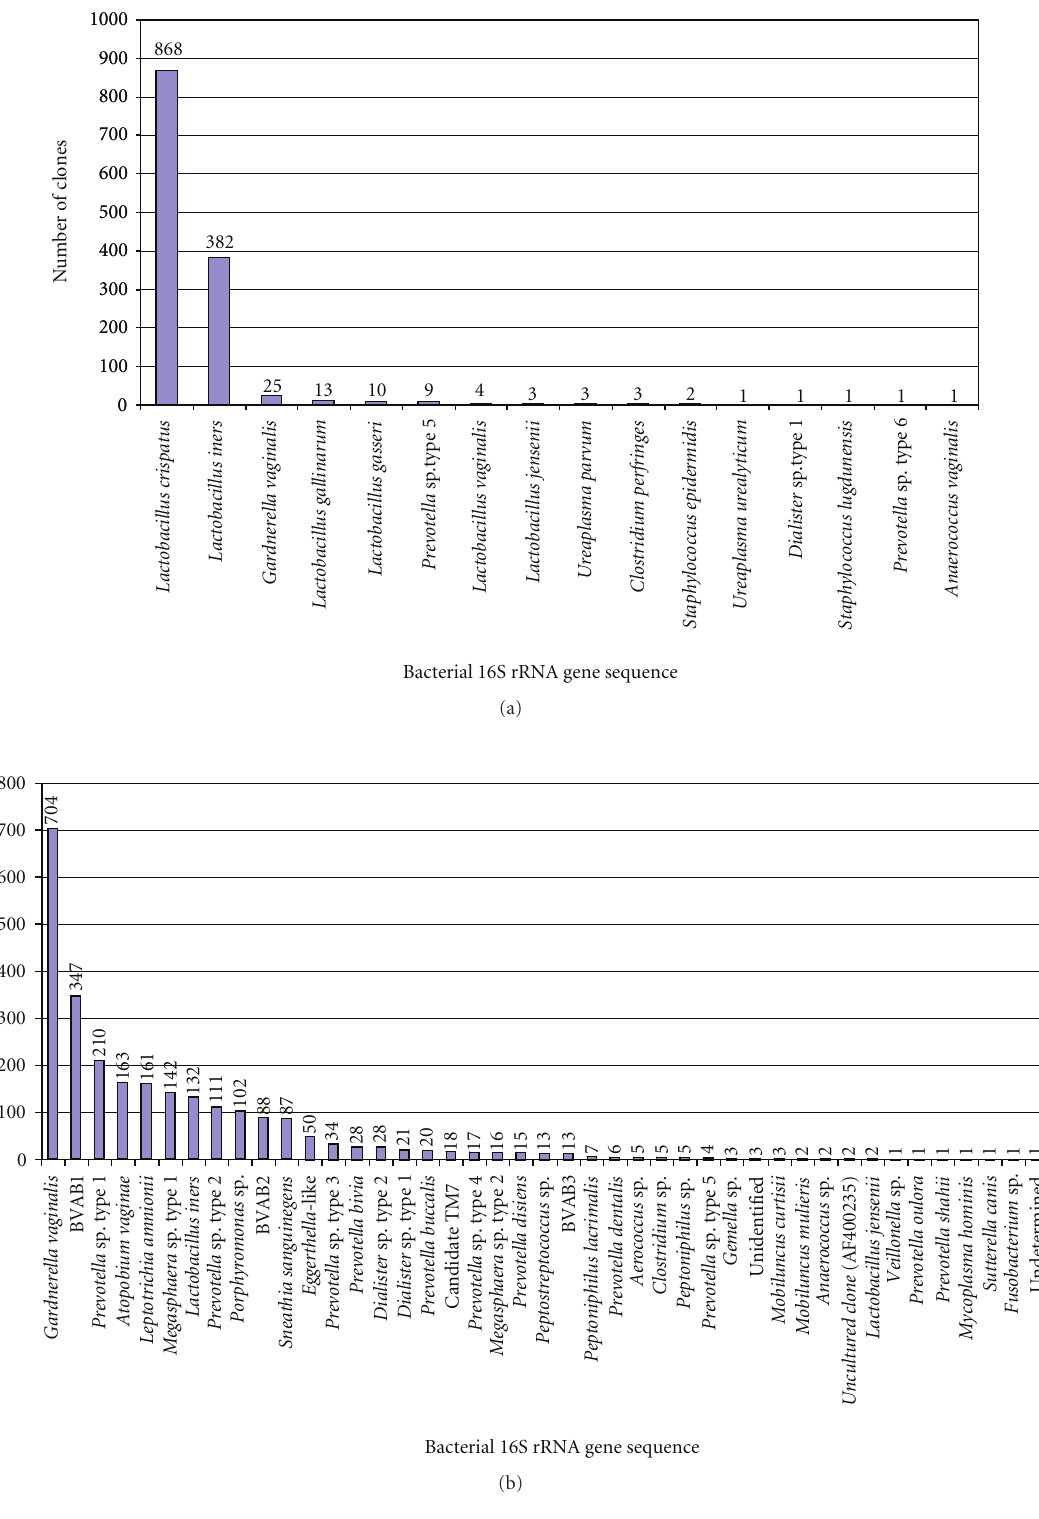
Figure 6: Summary data of rank abundance plots depicting the bacterial species detected in clone libraries from subjects without BV (A) and with BV (B) in our studies. Broad range PCR using primers 338f and 1407r along with clone library analysis of 1327 clones from 13 subjects without BV resulted in 16 phylotypes being detected. Similar analysis of 2577 clones from 23 clone libraries from 17 subjects with BV resulted in the detection of 44 di ff erent bacterial species. Vaginal bacterial species are indicated on the x-axis and the numbers of clones are indicated on the y-axis and above every bar. Subjects without BV have bacterial biotas dominated by lactobacilli while subjects with BV have a diverse bacterial biota. BVAB denotes bacterial vaginosis associated